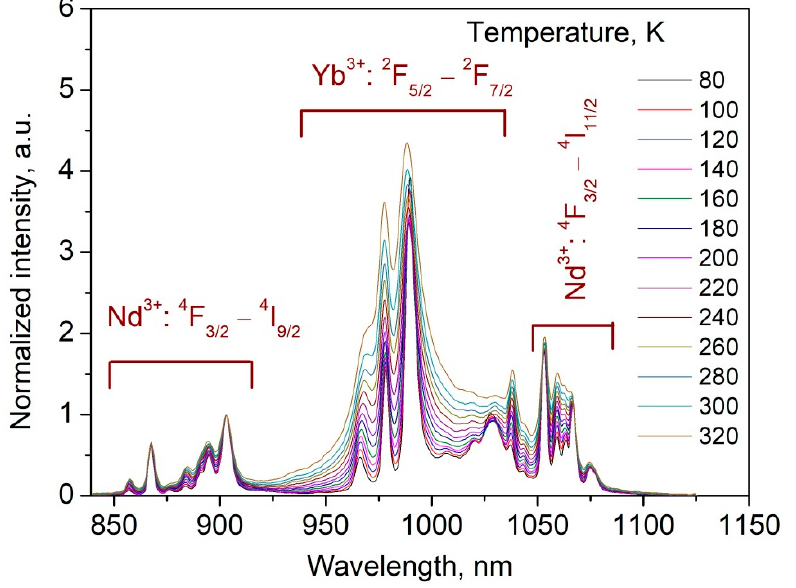
Figure 5. Normalized at 903 nm (Nd 3+ emission peak) spectra of Nd 3+ (0.1 mol.%), Yb 3+ (1.0 mol.%):YF 3 sample recorded in the 80–320 K temperature range. 790 nm excitation wavelength corresponds to 4 I 9/2 – 4 F 5/2 absorption band of Nd 3+ ions.